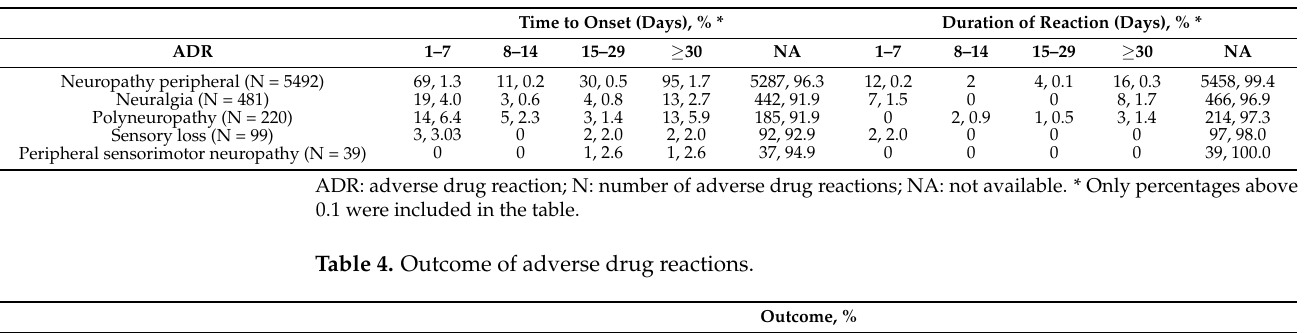
Table 3. Time to onset and duration of reaction.